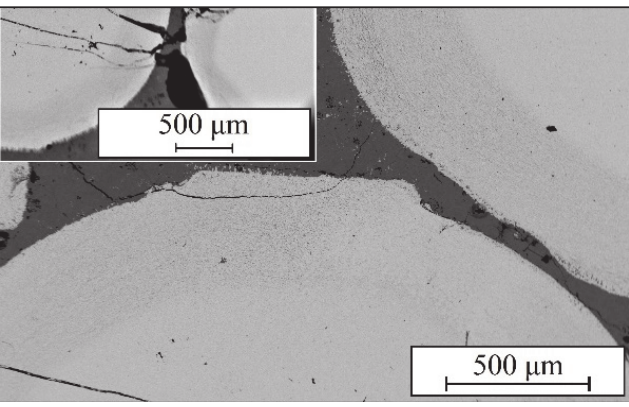
Fig. 2. Experimental sample from the laboratory of Tallinn University of Technology, showing the microstructure of the studied hardfacings. Composite hardfacing with 50 vol. % spherical WC-Co reinforcement. The numerical hardface data that were implemented in (1) and (2) for optimization correspond to this kind of